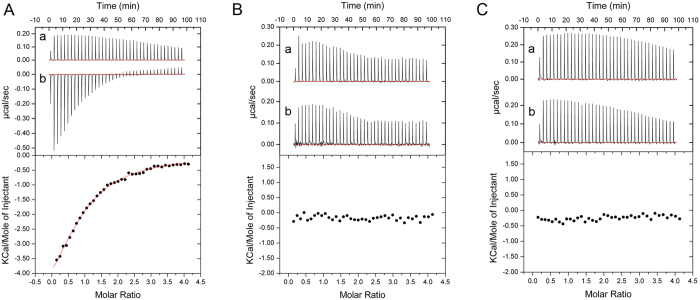
Representative ITC titrations of Pmt3 into Slx1RING+CT-Slx4CCD, Slx1RING-Slx4CCD, and Slx1RING+CT SIMmut-Slx4CCD.(A) The upper panel shows the experimental measurements of titrating Pmt3 into the buffer (a), and into Slx1RING+CT-Slx4CCD (b). The lower panel shows integrated binding isotherms of calorimetric titrations and the fitted curve. (B) The upper panel indicates the experimental measurements of titrating Pmt3 into the buffer (a), and into Slx1RING-Slx4CCD (b). The lower panel indicates the integrated isotherms of titrations. (C) The upper panel shows the experimental measurements of titrating Pmt3 into the buffer (a), and into Slx1RING+CT SIMmut-Slx4CCD (b). The lower panel indicates the integrated isotherms of titrations.